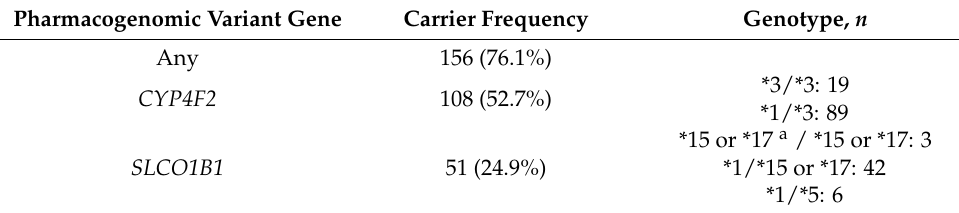
Table 2. Pharmacogenomic genotype frequencies of family medicine patients. There were no carriers of CACNA1S , CFTR , CYP2C19 , HLA-B , or RYR1 variant